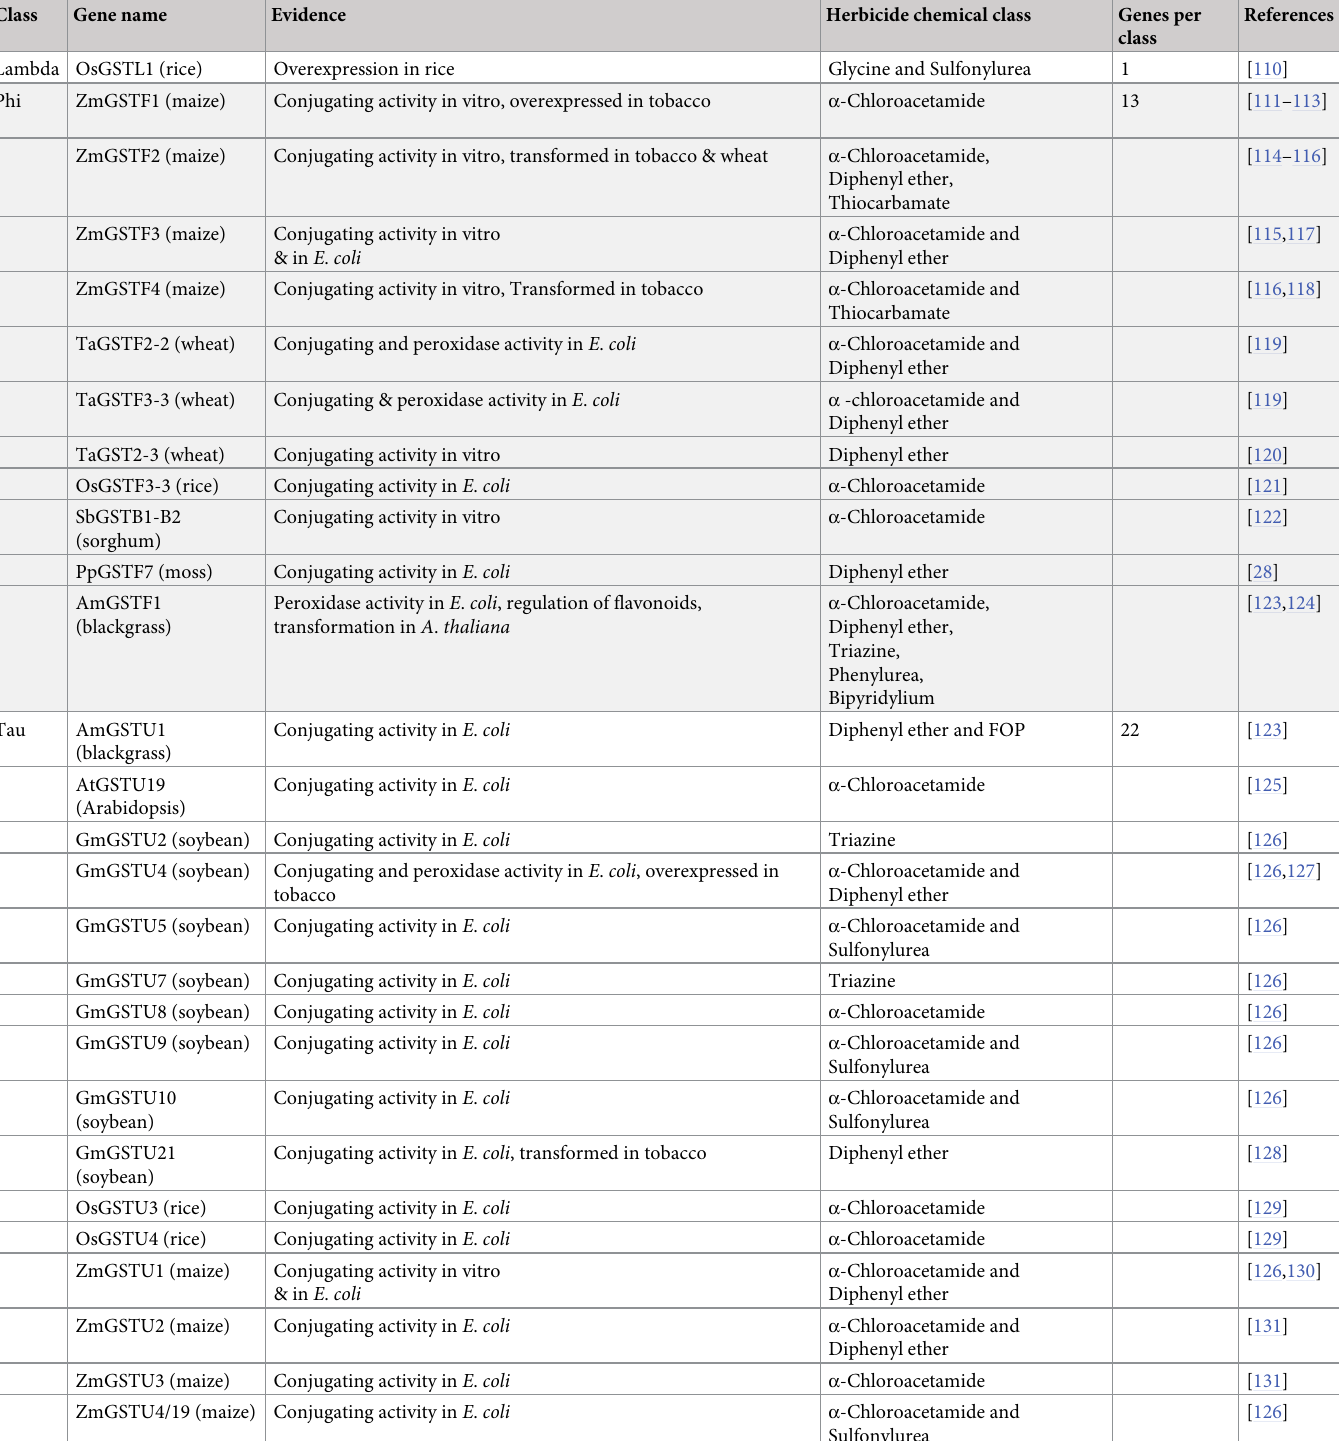
Table 3. Plant GST proteins that conjugate or confer resistance or tolerance to herbicides are members of classes phi, tau, and lambda. O . sativa and A . thaliana genes were renamed according to current nomenclature [22]. Gene numbers from this table are shown in Fig